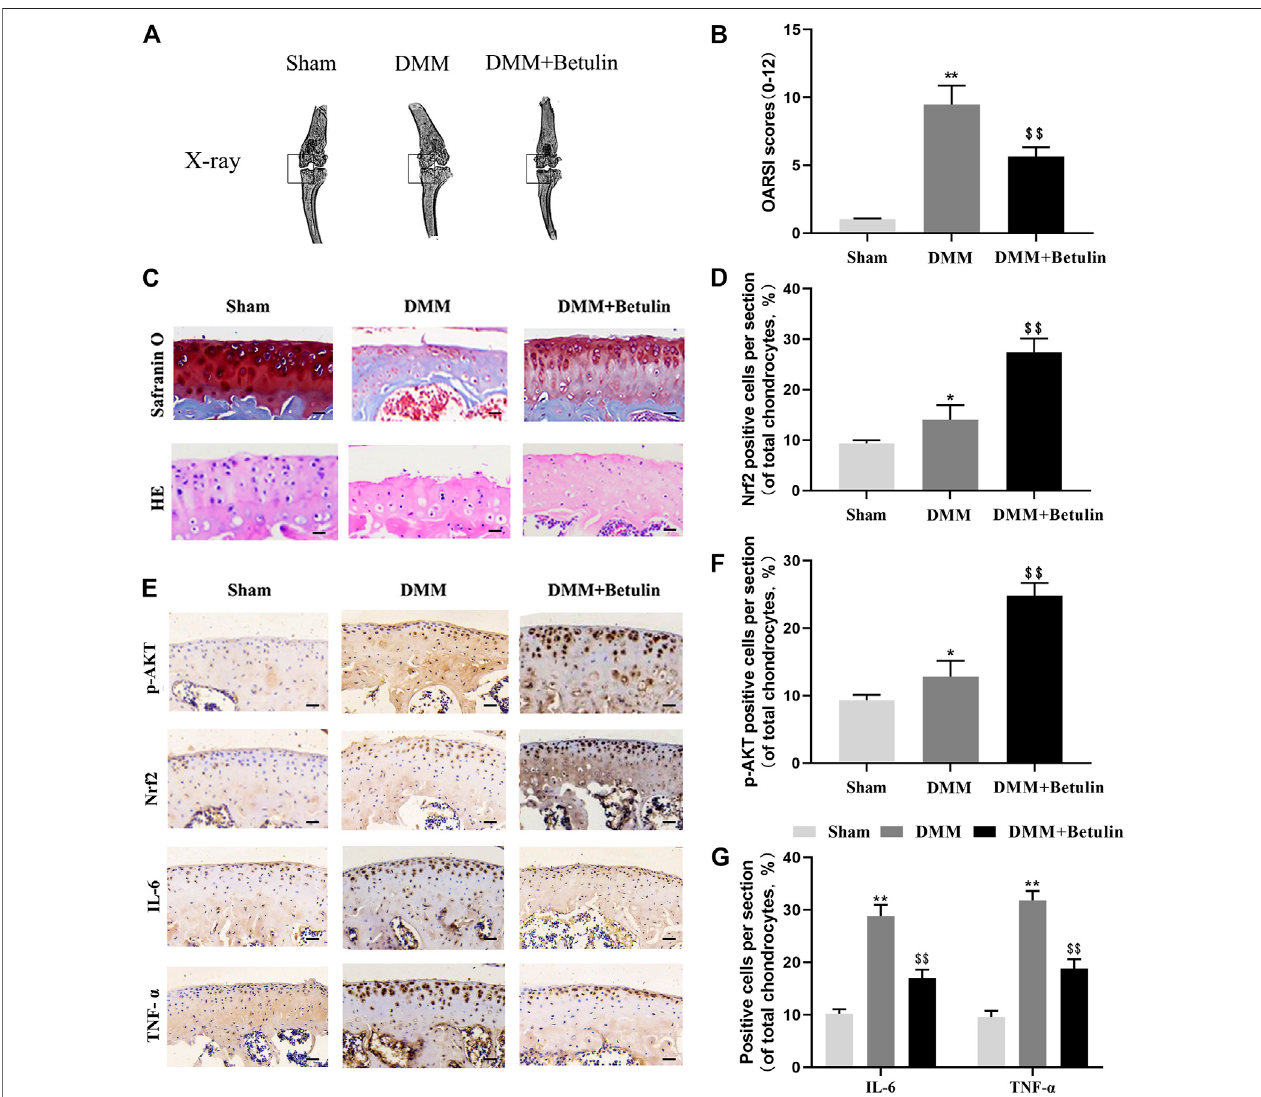
FIGURE 9 | Betulin inhibits the progression of DMM-induced OA in mice. The mice were randomly divided into three groups: the Sham group, DMM group, and DMM + Betulin group. The sham operation was performed in the Sham group, and the OA model was established in the DMM and DMM + Betulin groups. Eight weeks after operation, (A) X-ray imaging ofthe knee joints ofthe mice in the different experimental groups were performed, and betulin processing alleviated the stenosis ofthe jointspace. (B – C) ThekneejointsofthemiceinthedifferentexperimentalgroupswerestainedwithSOstainingandHEstaining(scale:50 μ m),andthehistological changes of OA were evaluated by the score of the OARSI. (E) Immunohistochemical staining of p-AKT, Nrf2, IL-6, and TNF- α expression in the cartilage specimens (scale:50 μ m). (D – G) Thepercentage ofp-AKT, Nrf2, IL-6, and TNF- α positive cells ineach section wasquantitatively analyzed byImage-ProPlus software. Thedata in the fi gure show that the average value is ± SD, ** p < 0.01 compared with the control group, $$ p < 0.01 compared with the DMM group, n (cid:2) 6.